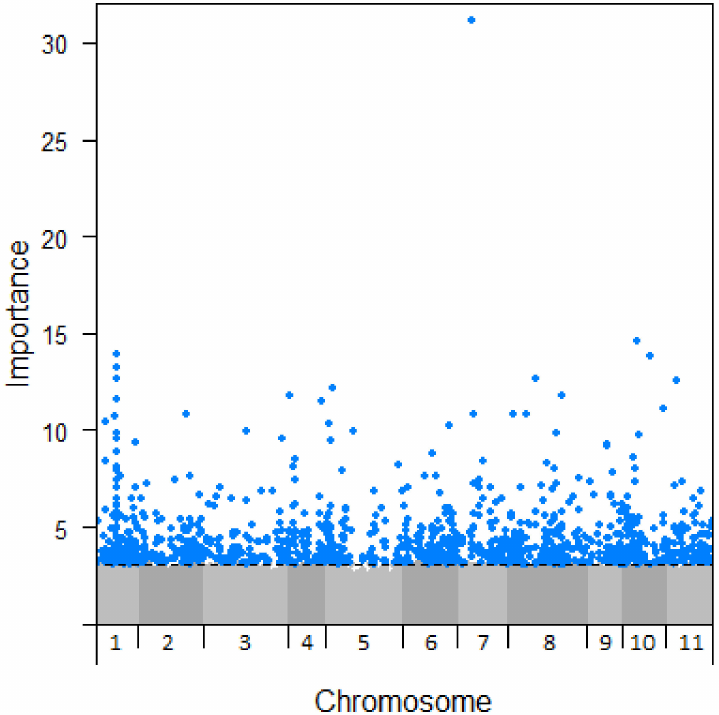
Figure 4. Manhattan plot of SNP importance to drought damage (not accounting for spatial variance) across Eucalyptus globulus chromosomes. A threshold of importance >3.1 was set in order to capture a number of SNPs similar to that found to be important in the analysis using climate